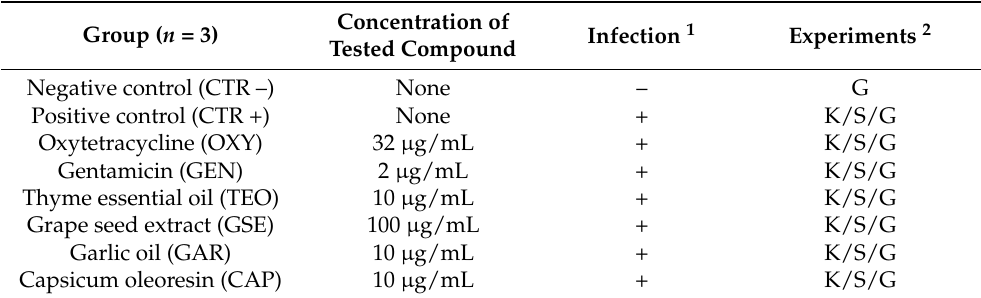
Table 5. Experimental designs describing treatment groups, the concentrations of the tested com- pound, and in which experiments they were carried out. Concentration of Group ( n = 3) Infection 1 Experiments Tested Compound